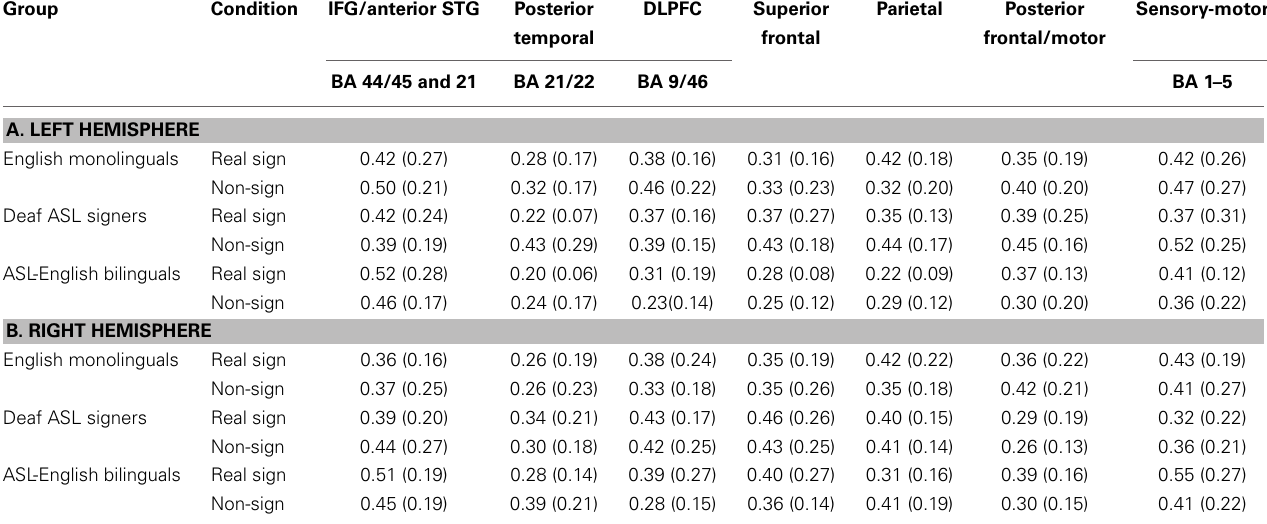
Table 3 | Participants’ brain activation, Mean (Standard Deviation) brain activation as measured in fnirs percent signal intensity during sign repetition task by condition and brain